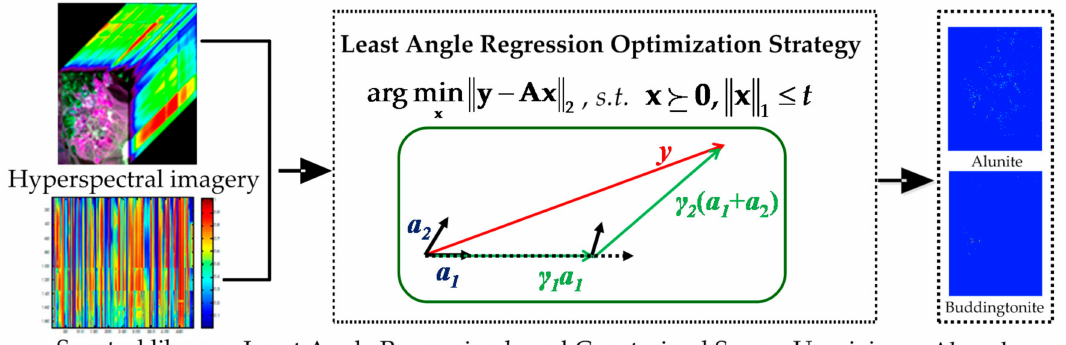
Figure 1. Schematic of least angle regression-based constrained sparse unmixing